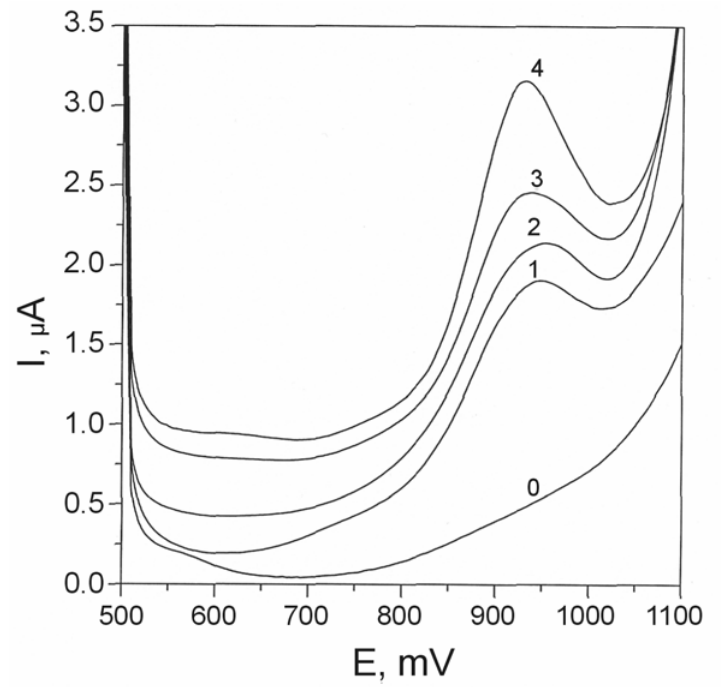
Figure 1. DP voltammograms of [Ru(bpy) ] 2+ at SPE (1), DNA/SPE prepared in situ in DNA solution 3 of 10 µg/mL (2), 20 µg/mL (3), 50 µg/mL (4). Curve (0) is blank. Conditions: 5x10 -6 mol/L Ru(bpy) ] 2+ in 2x10 -1 mol/L acetate buffer solution pH 5.40 with 5x10 -2 mol/L NaCl, scan rate 1 3